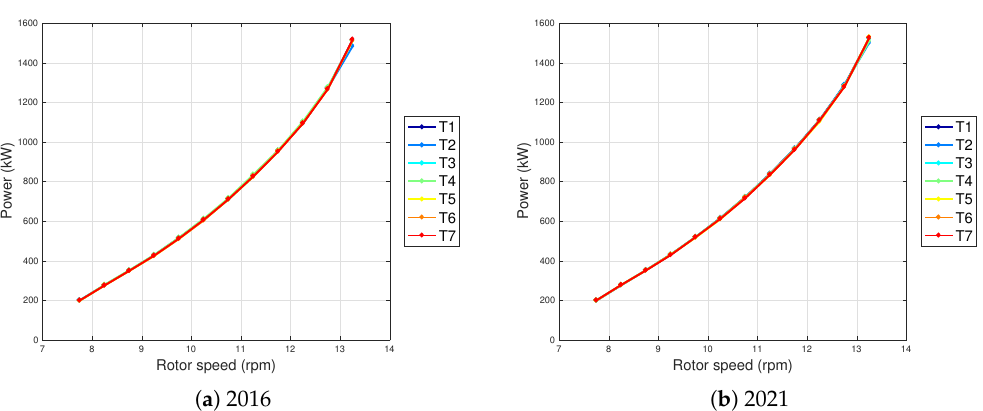
Figure 10. Rotor speed–power curve for the whole wind farm, computed using the binning method.